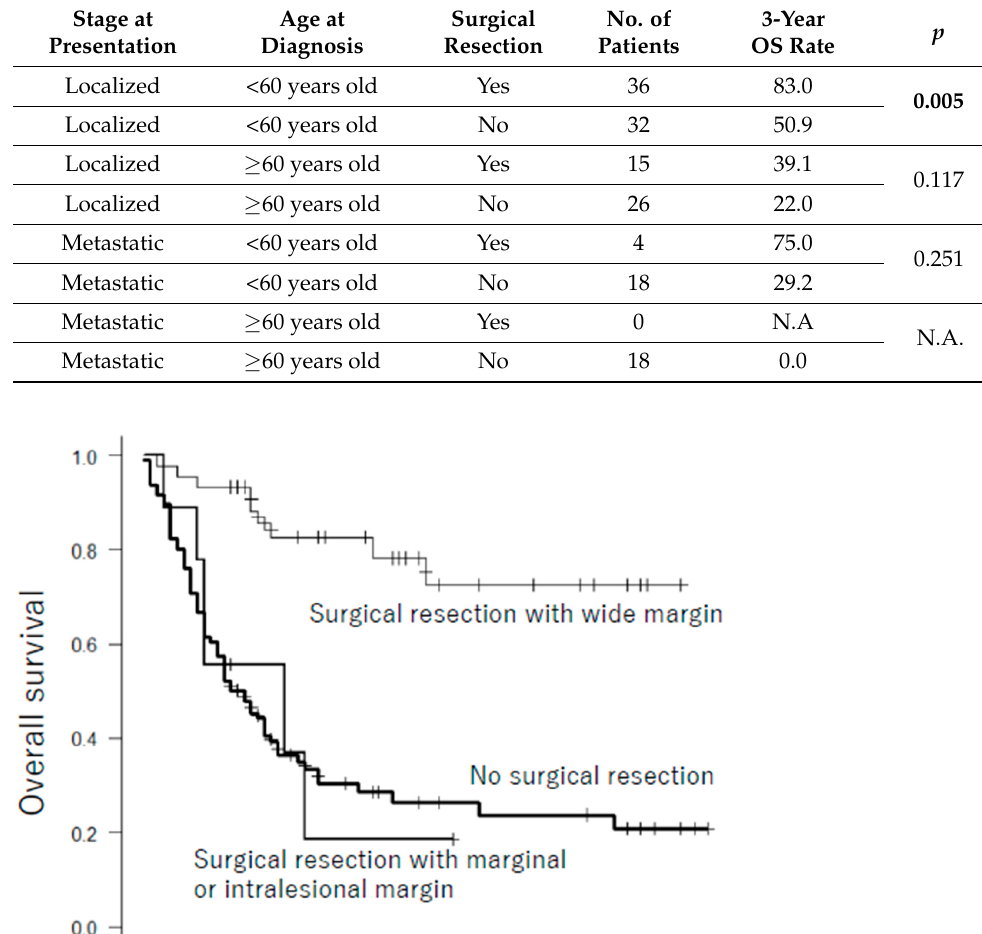
Table 6. Subgroup analysis of pelvic osteosarcoma according to the stage, age, and surgical resection.